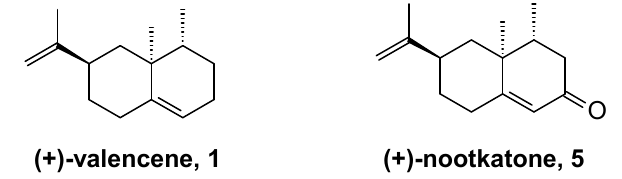
Figure 1. Structure of (+) ‐ valencene and (+) ‐ nootkatone .